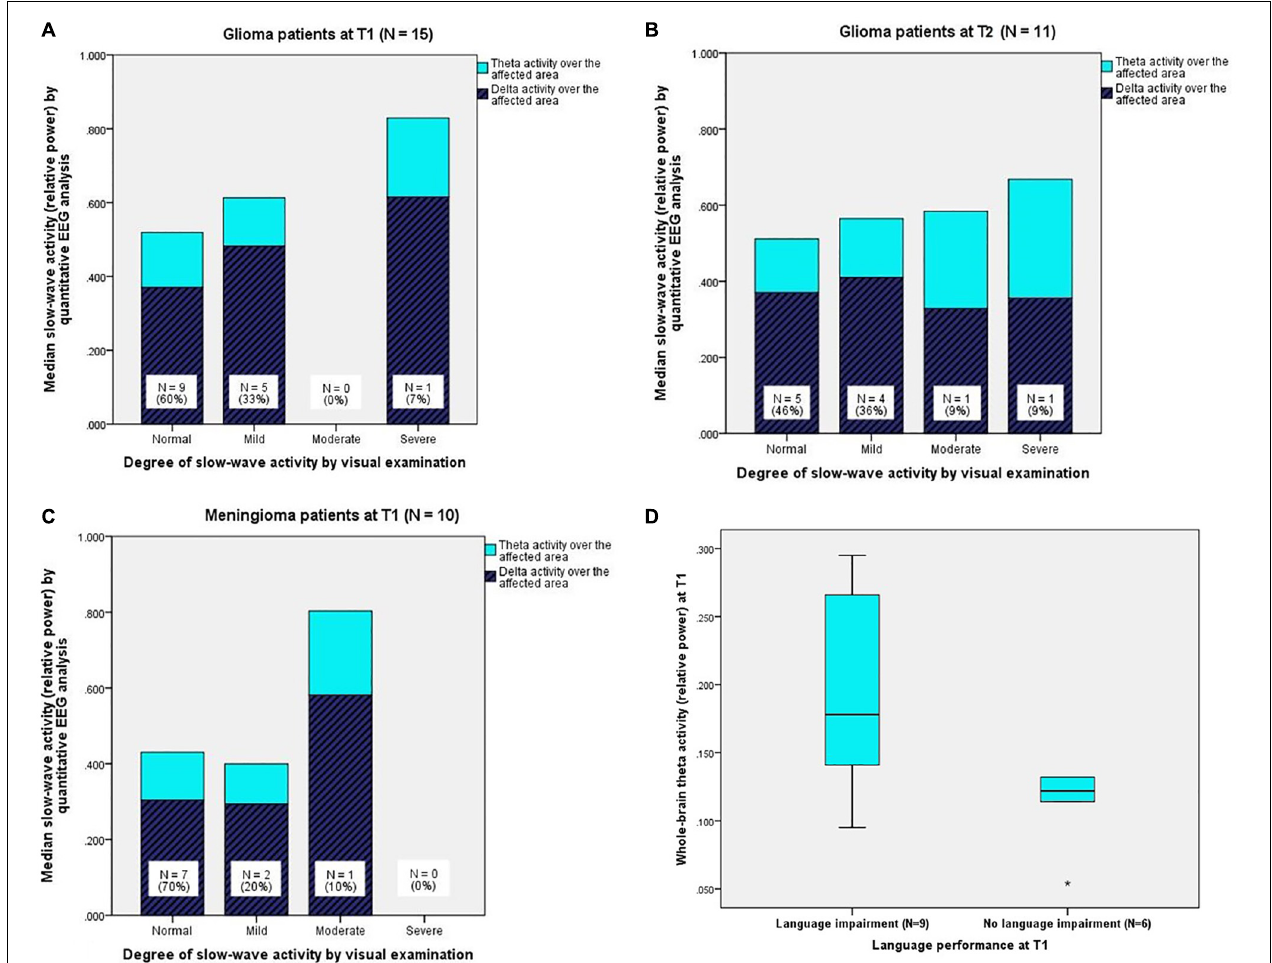
FIGURE 2 | (A) ( Upper left ) Quantitatively analysed slow-wave activity (relative delta and theta power) over the affected area for every degree of slow-wave activity from visual EEG examination in glioma patients at T1 and (B) ( upper right ) at T2. (C) (Below left) Quantitatively analysed slow-wave activity (relative delta and theta power) over the affected area for every degree of slow-wave activity from visual EEG examination in meningioma patients at T1 (N.B. Meningioma patients did not undergo EEG registration at T2). (D) (Below right) Boxplots of theta activity over the whole brain for glioma patients with language impairment ( N = 9) and glioma patients without language impairment ( N = 6) at T1. The boxes contain 50% of the data (interquartile range), including the median (black horizontal line), and the vertically extending lines (whiskers) present the upper and lower quartiles of the data. “*” indicates an outlier > three times the interquartile